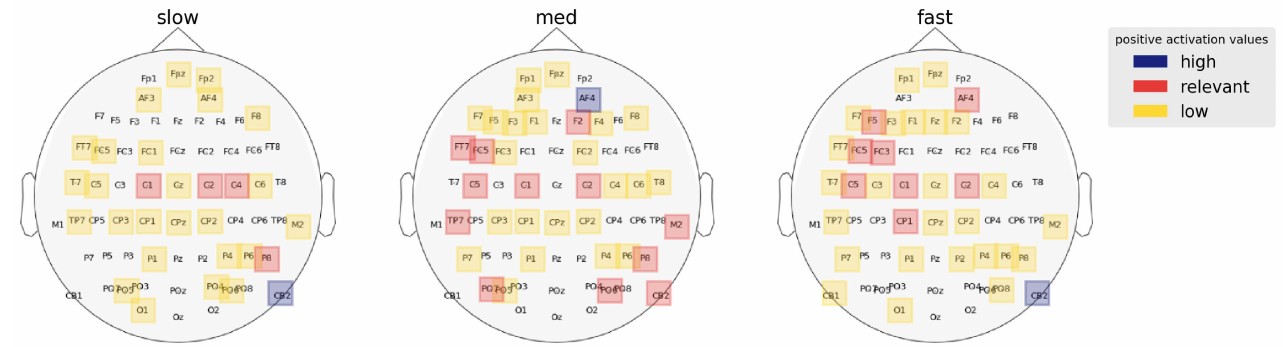
Figure 7. Regions of interest for each RT category as identified by the CNN model. Activation scores are averaged across the frequency bands to acquire salient regions of each RT category. Left frontal activation is inversely proportional to RTs.